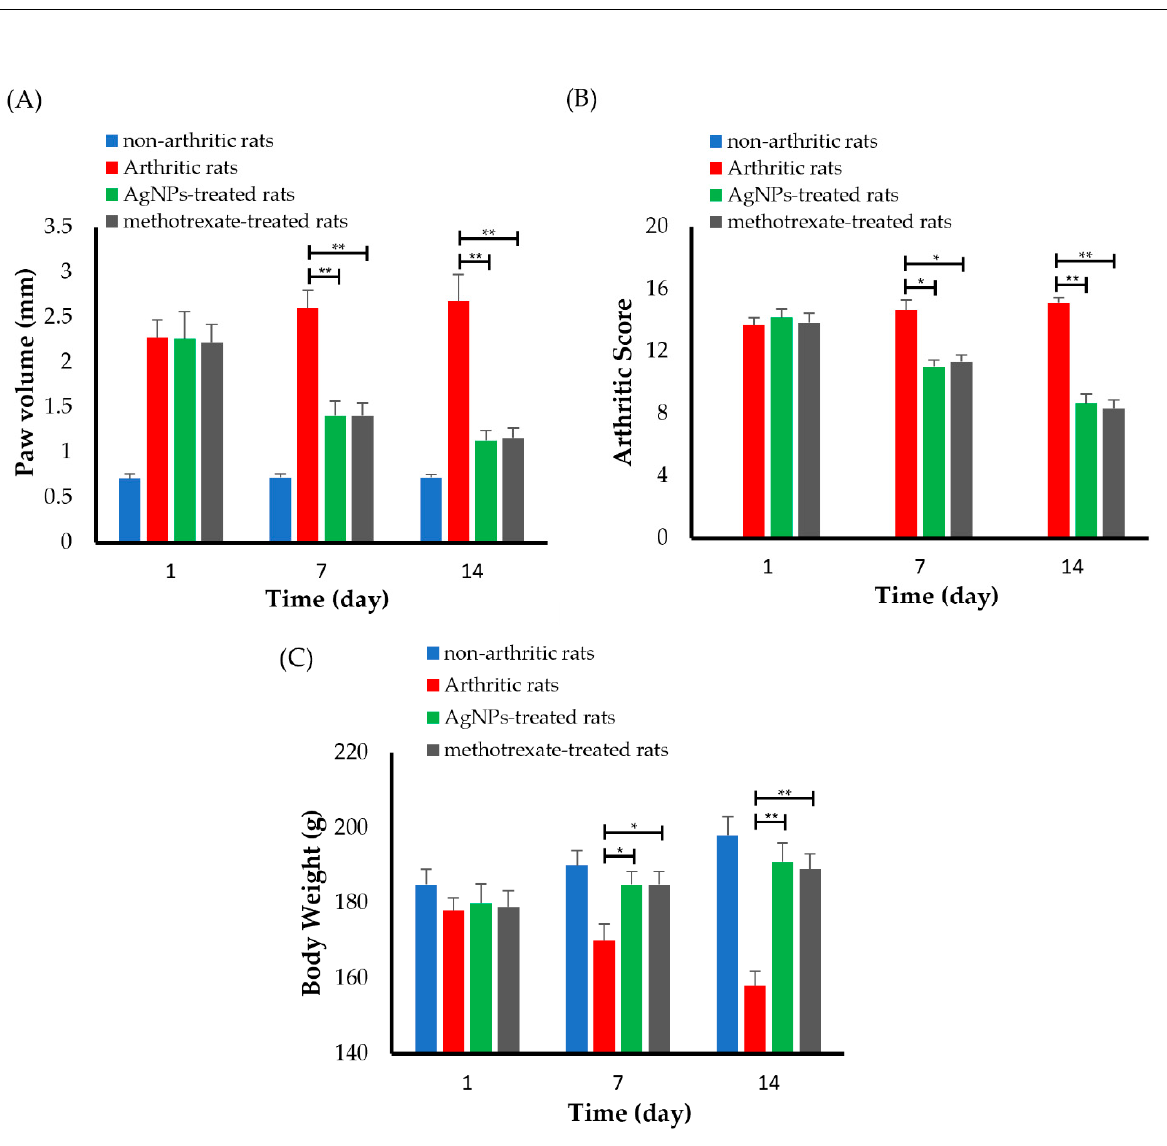
Figure 6. Anti-arthritic activity of silver nanoparticles. ( A ) Paw volume, ( B ) arthritic score, and ( C ) body weight of rats treated with either silver nanoparticles or a reference drug, methotrexate. * p < 0.5 and ** p < 0.01 vs. arthritic rats.